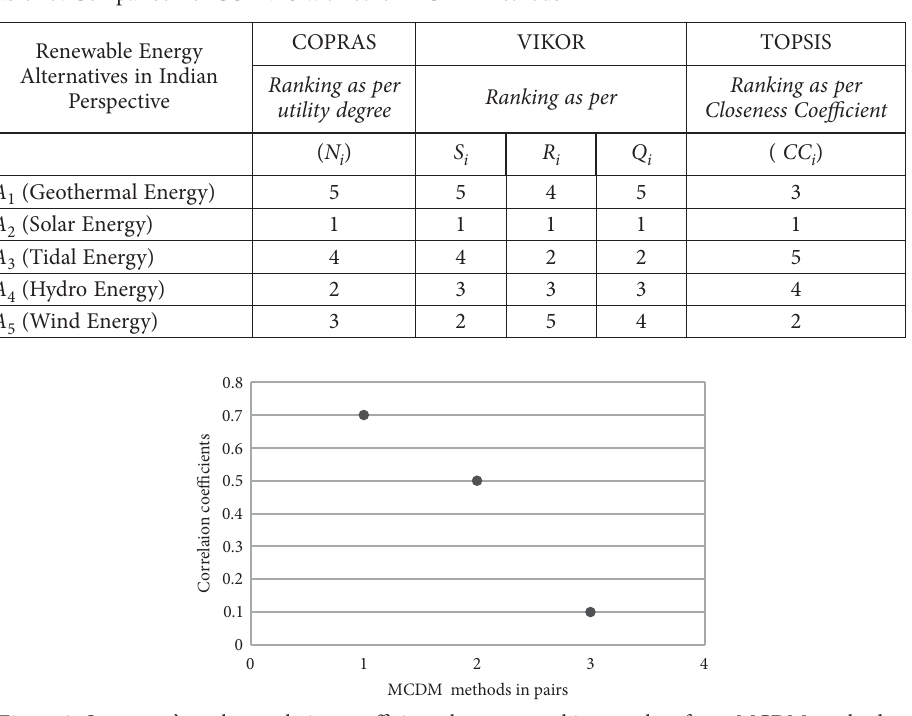
Figure 2. Spearman’s rank correlation coefficients between ranking results of two MCDM methods (1 – COPRAS and VIKOR, 2 – COPRAS and TOPSIS, 3 – VIKOR and